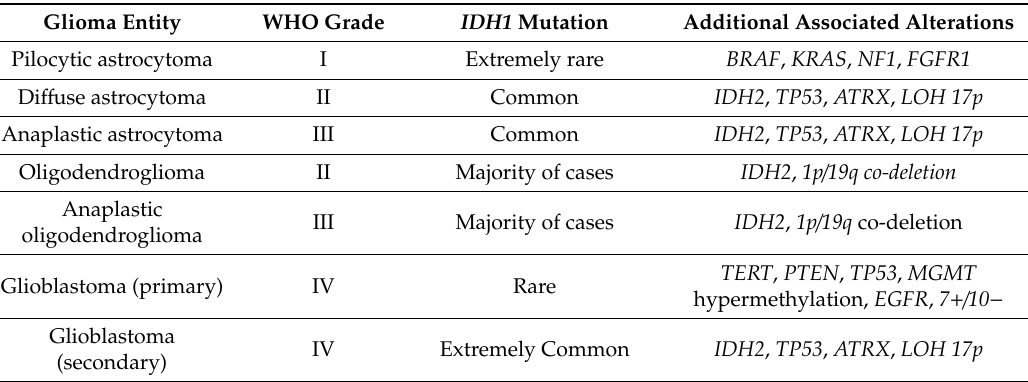
Table 1. Common genetic and chromosomal aberrations associated with the major glioma subtypes [6]. Abbreviations defined below the